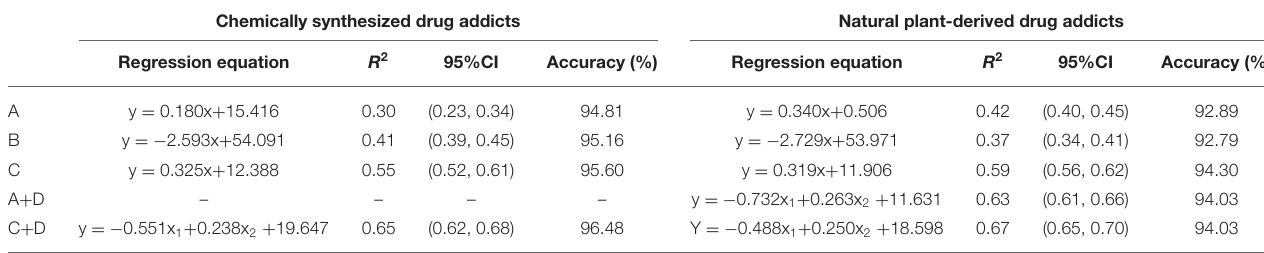
TABLE 6 | Accuracy statistics of different methods to estimate the VO 2max ( n = 30). Chemically synthesized drug addicts Natural plant-derived drug addicts Regression